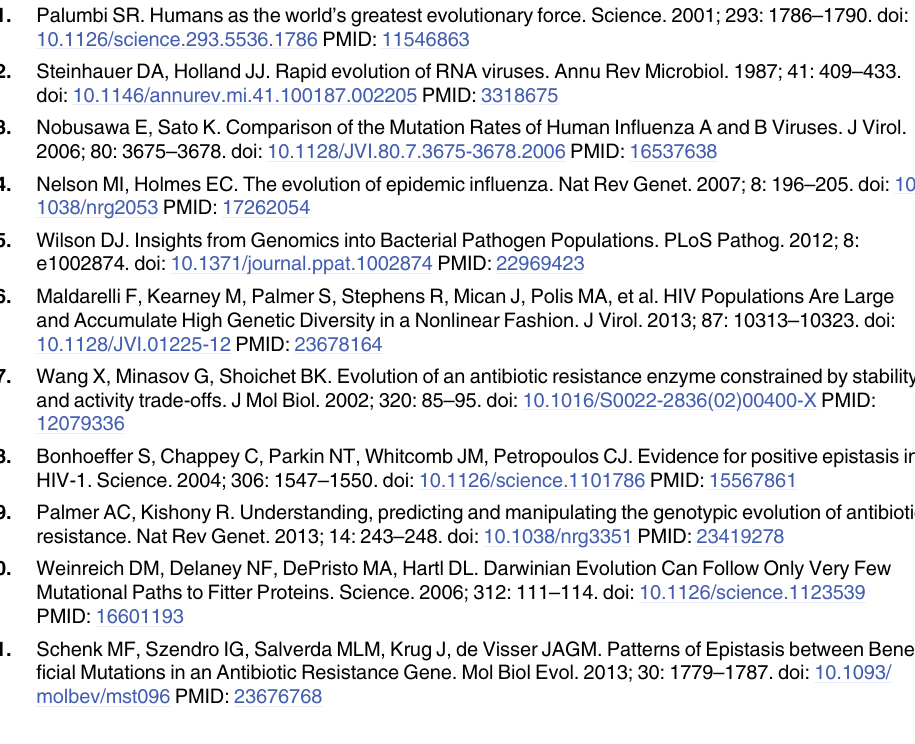
S6 Fig. The expected number of true positive epistatic pairs (which is given by OP – EFP, see Materials and Methods) in the inter-gene (orange line) and intra-gene (blue line) epistasis analysis, at each FDR. Notations as in S1